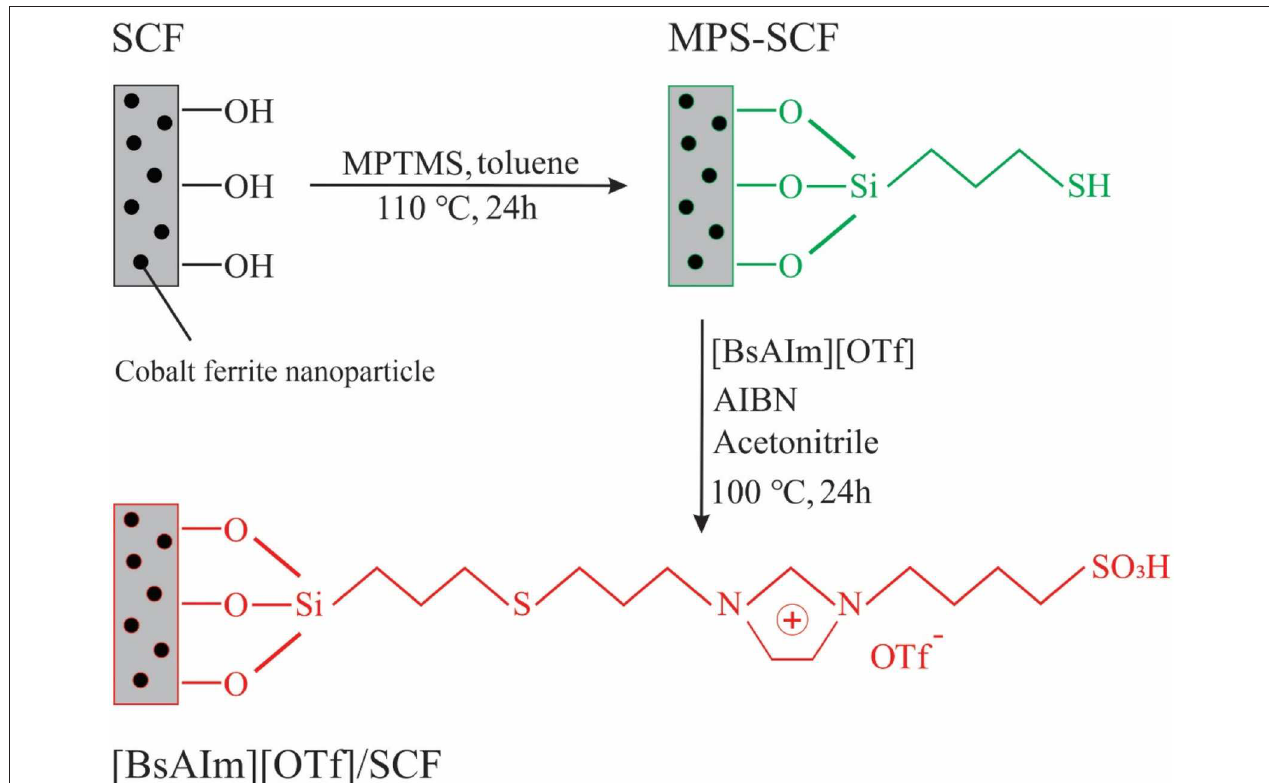
FIGURE 3 | Schematic of the synthesis process of [BsAIm][OTf]@SiO 2 /CoFe 2 O 4 [Redrawn with modification from Zhen et al.